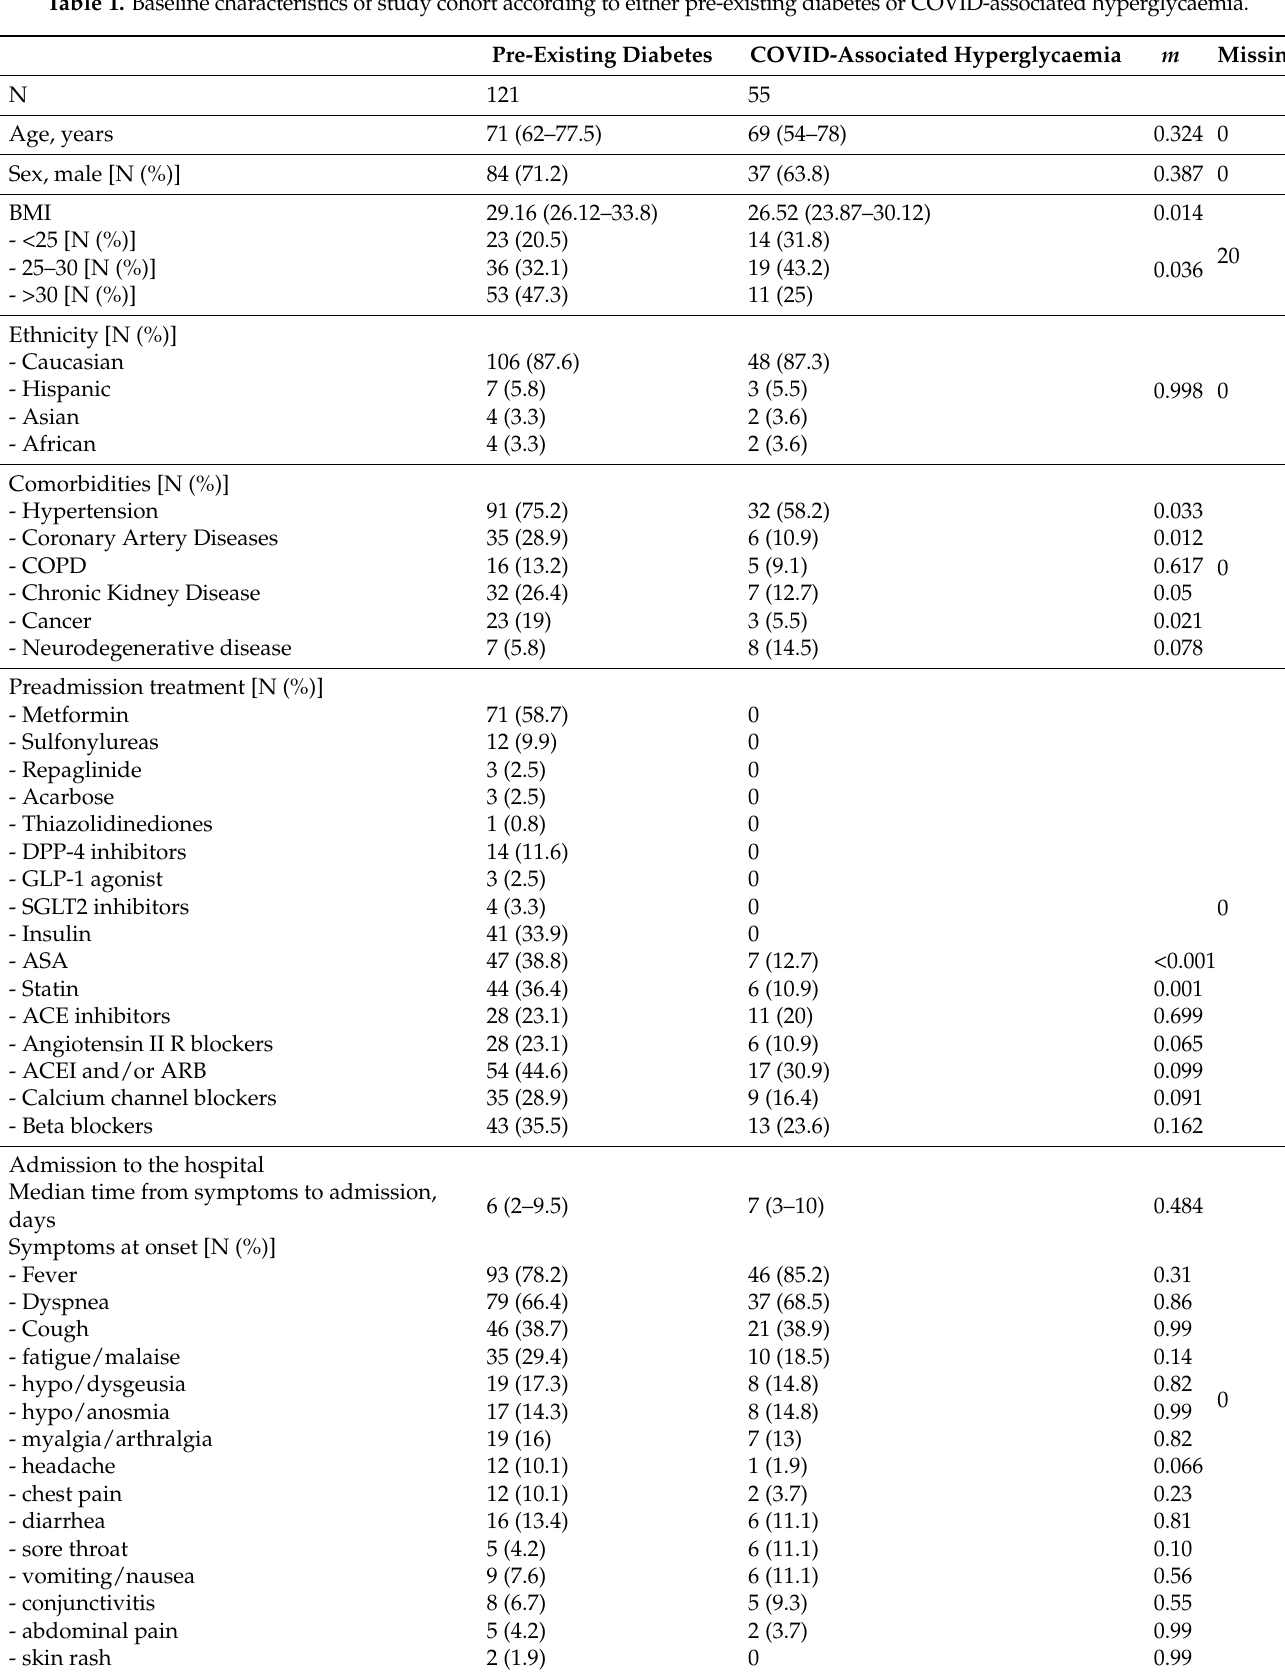
Table 1. Baseline characteristics of study cohort according to either pre-existing diabetes or COVID-associated hyperglycaemia. Pre-Existing Diabetes COVID-Associated Hyperglycaemia m